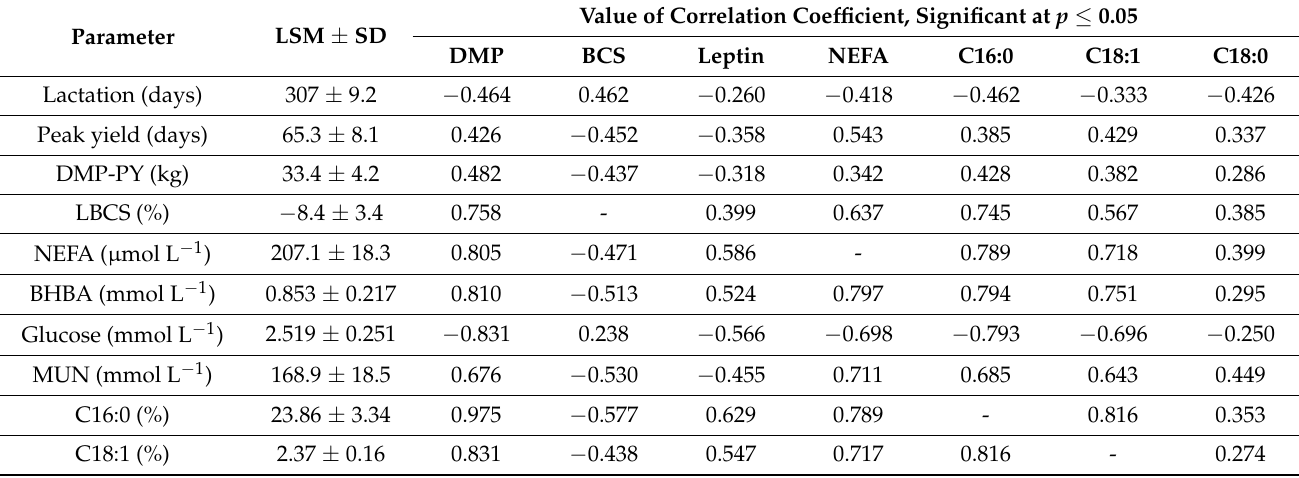
Table 6. Selected parameters of production and energy metabolism, as well as correlations between